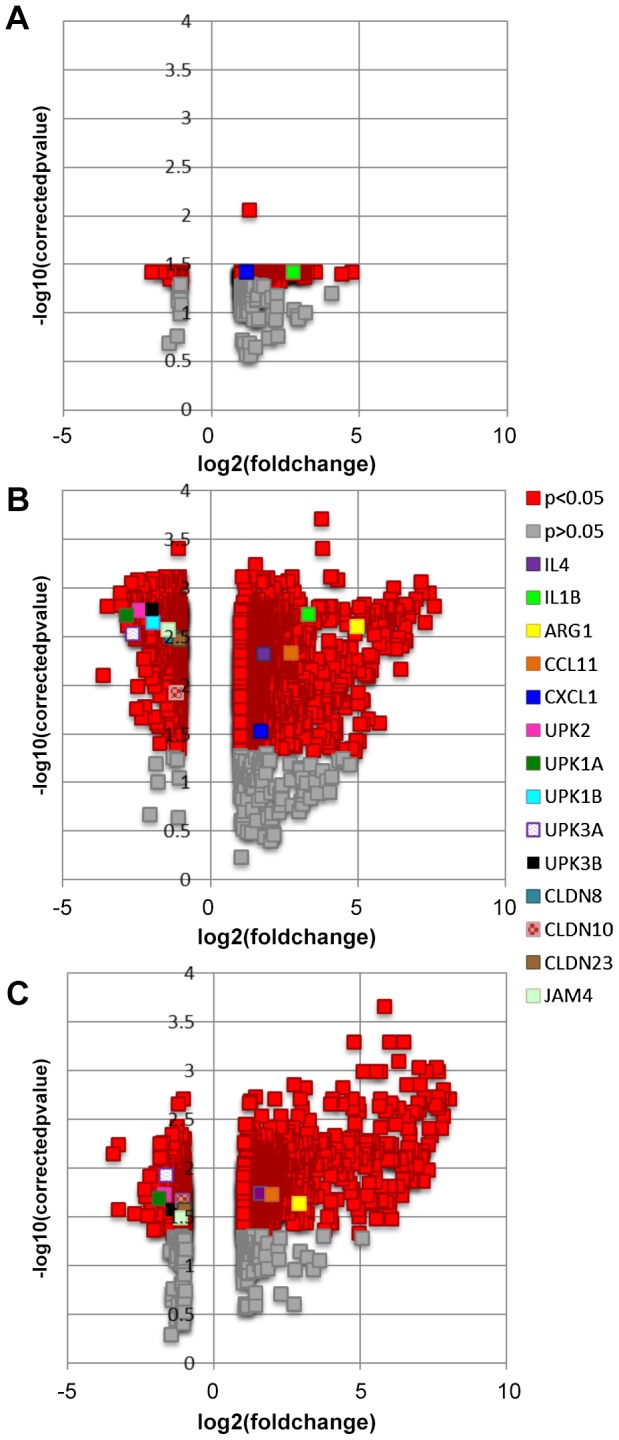
Volcano plots of differentially transcribed genes in egg-injected bladders.Separate plots are shown comparing microarray-derived gene transcription in egg-injected bladders relative to control vehicle-injected bladders (A, one week post-injection; B, three weeks post-injection; C, five weeks post-injection). Log fold changes are plotted on the x-axes and negative log10 p-values are plotted on the y-axes. Red and other non-dark gray, colored symbols denote statistically significant (p<0.05) changes in gene transcription. Gray symbols denote statistically insignificant (p>0.05) changes in change transcription. Legend for individual, selected genes of interest applies to all three panels. For clarity, each selected gene of interest with multiple microarray probes has been denoted using the probe featuring the greatest differential signal for that gene.